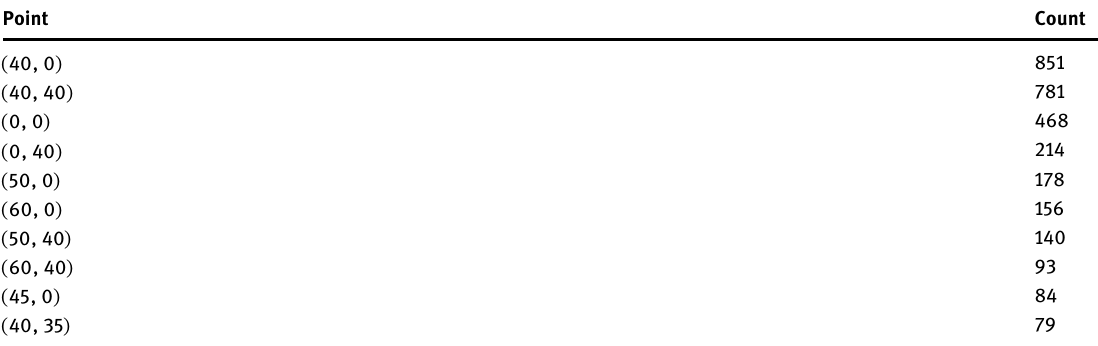
Table 3. For all models, we use the Gaussian copula to fi nd the form of the multivariate distribution